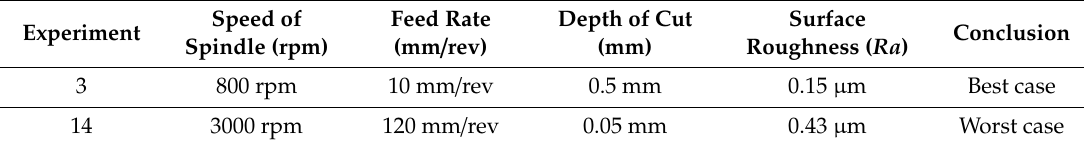
Table 3. Maximum and minimum surface roughness.